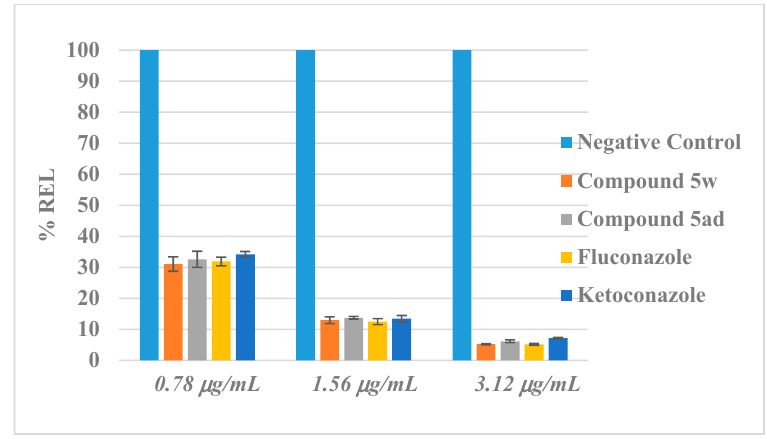
Figure 2. Relative Ergosterol Level (REL) of C. albicans (ATCC 24433) after treatment with compounds 5w and 5ad fluconazole and ketoconazole.